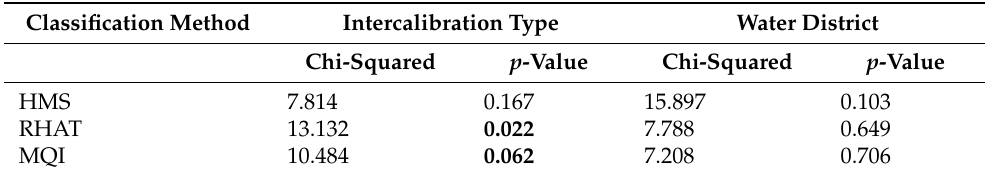
Table 2. Results of the Kruskal–Wallis rank sum test for the three assessment methods per ICT and water district. Values in bold are significant ( p ≤